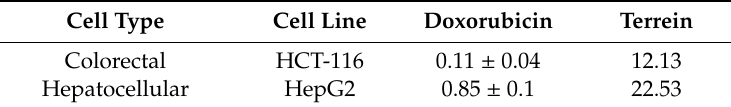
Table 4. In vitro cytotoxic activity (IC 50 , µ M) of terrein against human carcinoma cells (HCT-116 and